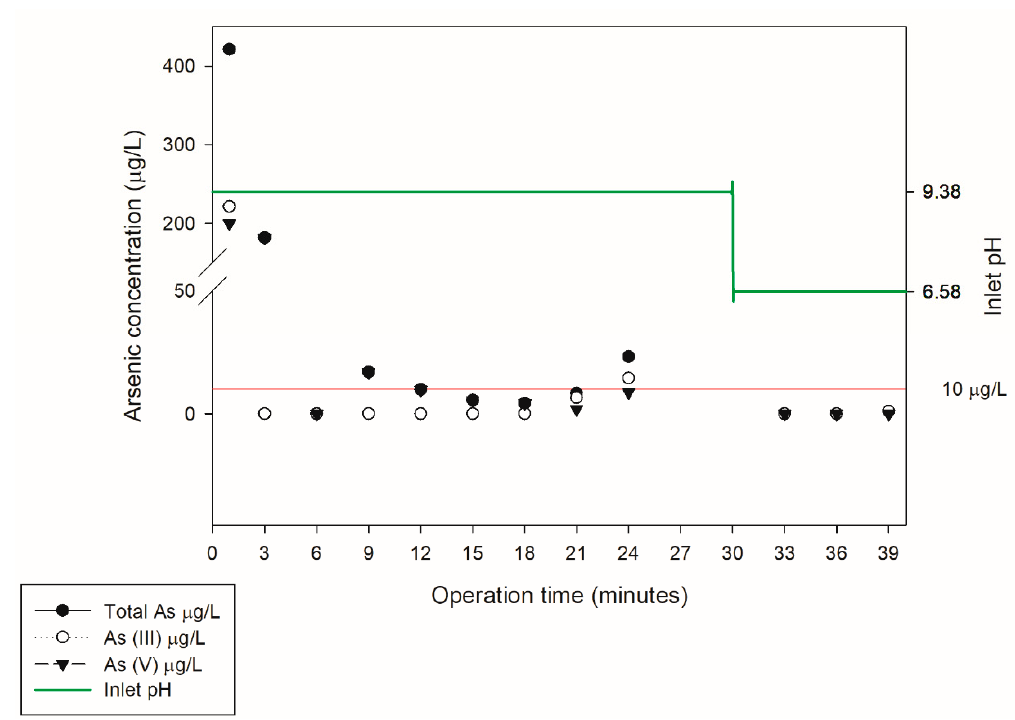
Figure 3. Concentration of arsenic and their species during treatment.